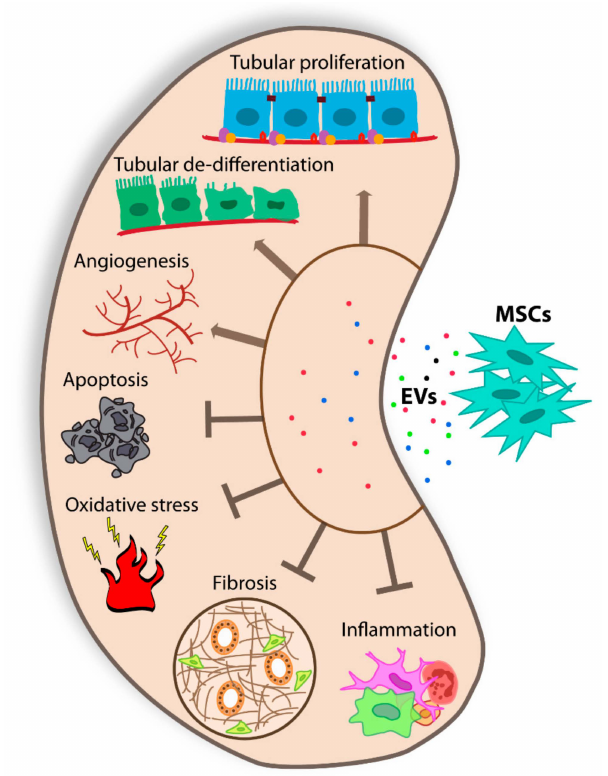
Figure 1. Schematic representation of the e ff ects of MSC-EVs on renal